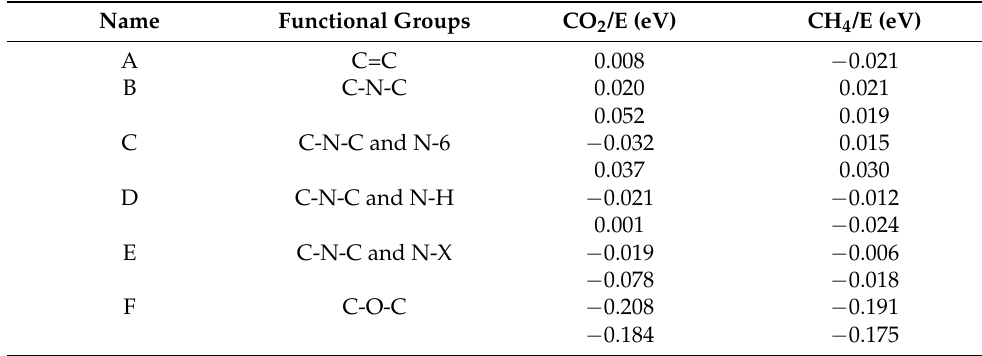
Table 4. Binding energy between CMFs and gases (CO 2 and CH 4